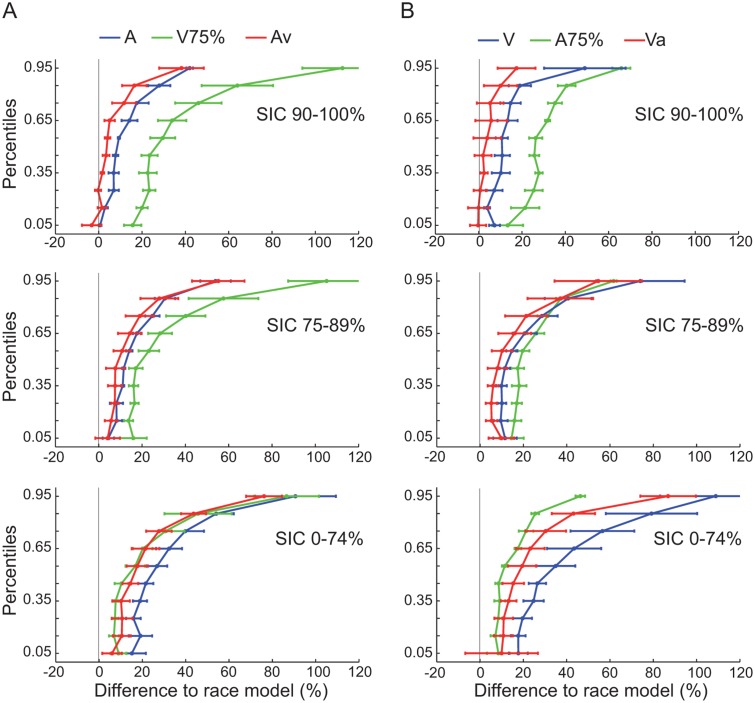
Reaction time: race model results.The RTs were sorted by the SICs (rows) and both modalities (A: audio, B: visual) pooled across all animals. The X-axis displays the cumulative reaction time differences to the race model for each modality (± SEM). A value of 0 at the X-axis corresponds to the prediction from the combination of both unimodal CDF’s. The blue curve displays the unimodal condition, the green curve the RTs at the supportive value and the red curve the bimodal class, respectively.